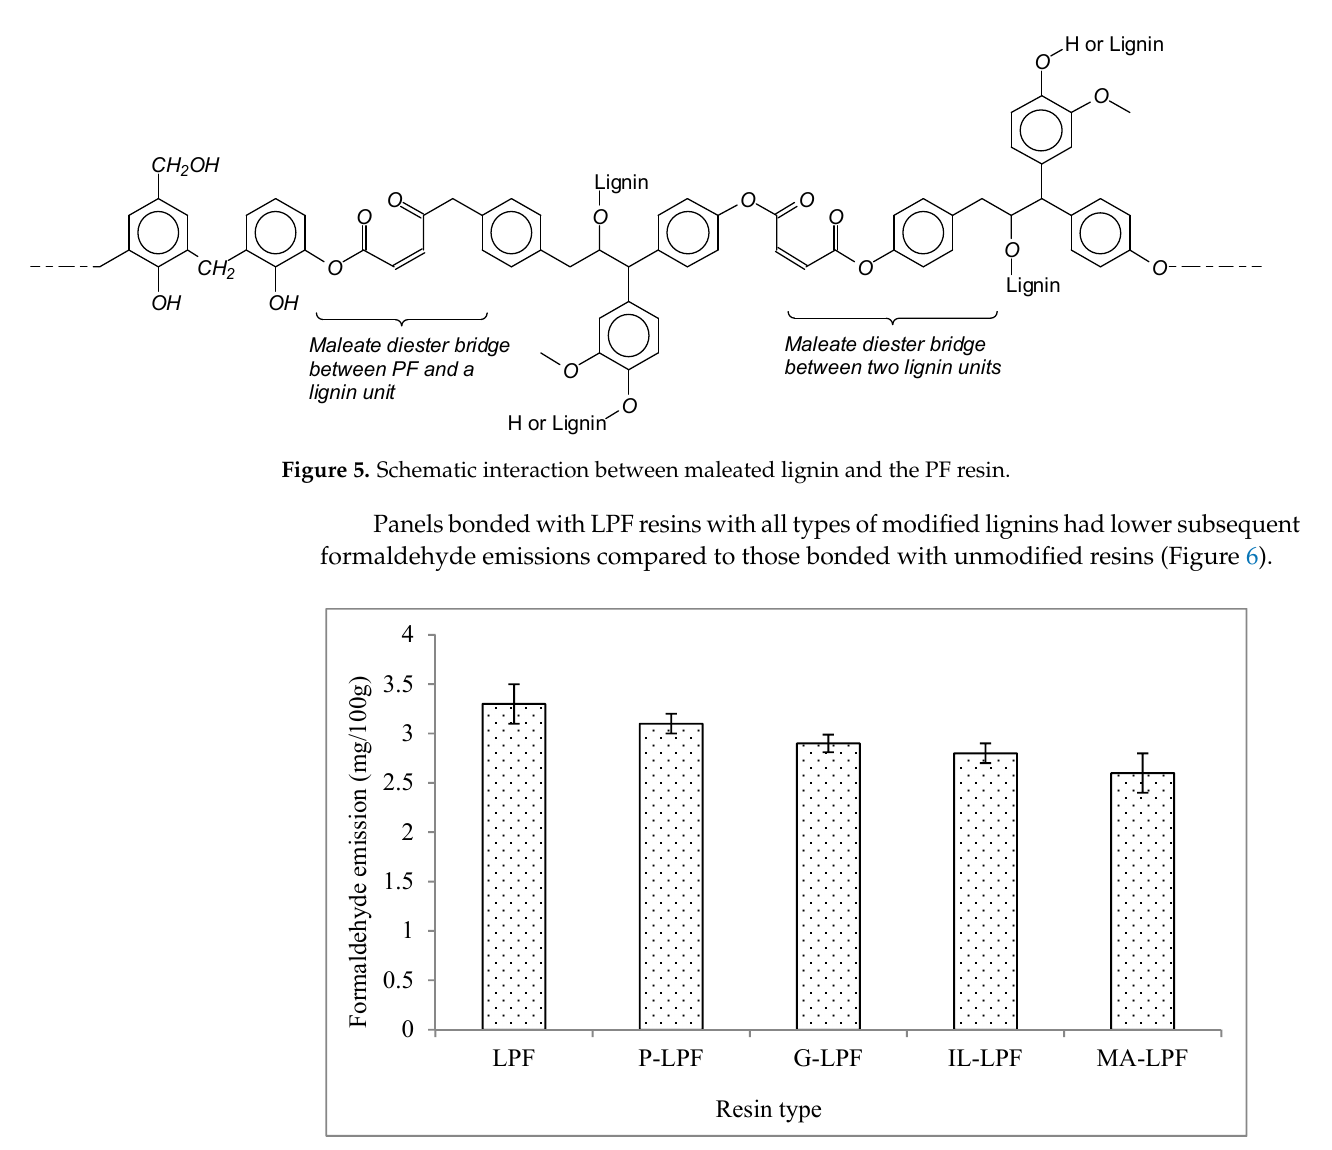
Figure 4. Different bridges between the maleated lignin and PF resin.